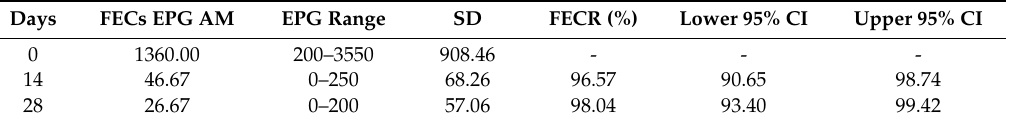
Table 1. Initial (Day 0 ) and post-treatment (D + 14 and D + 28 ) fecal egg counts (FECs) expressed as mean of egg per gram (EPG), relative standard deviation (SD) and percentage of fecal eggs count reduction (FECR%), with their 95% lower and upper confidence intervals (CIs) after an oral treatment of ivermectin (IVM) in mules naturally infected by cyathostomins.